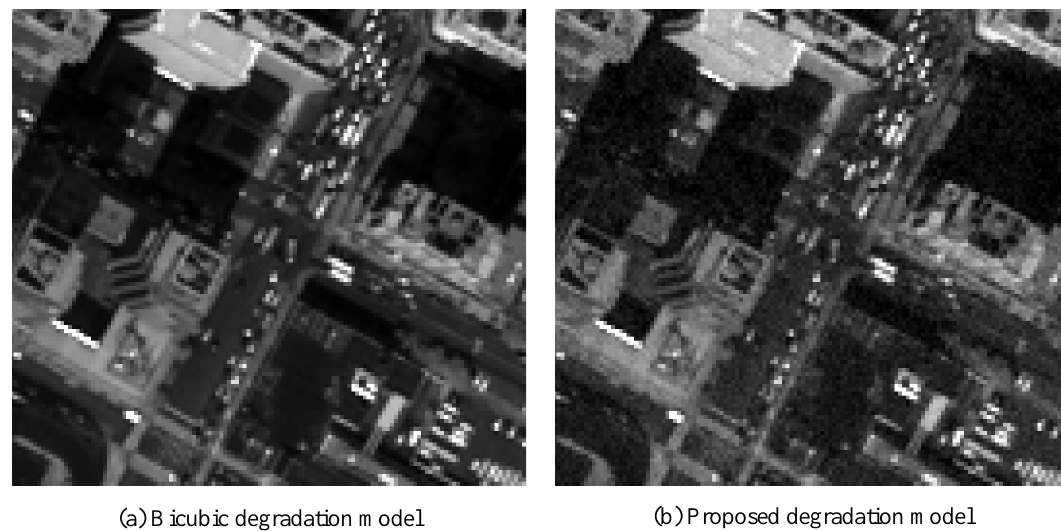
Figure 2. Comparison of low-resolution images: ( a ) bicubic degradation model and ( b ) proposed degradation